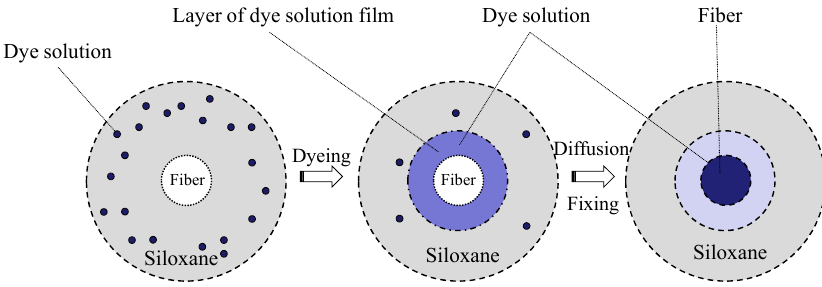
Figure 1. Schematic diagram of reactive dye in a siloxane non-aqueous dyeing system.